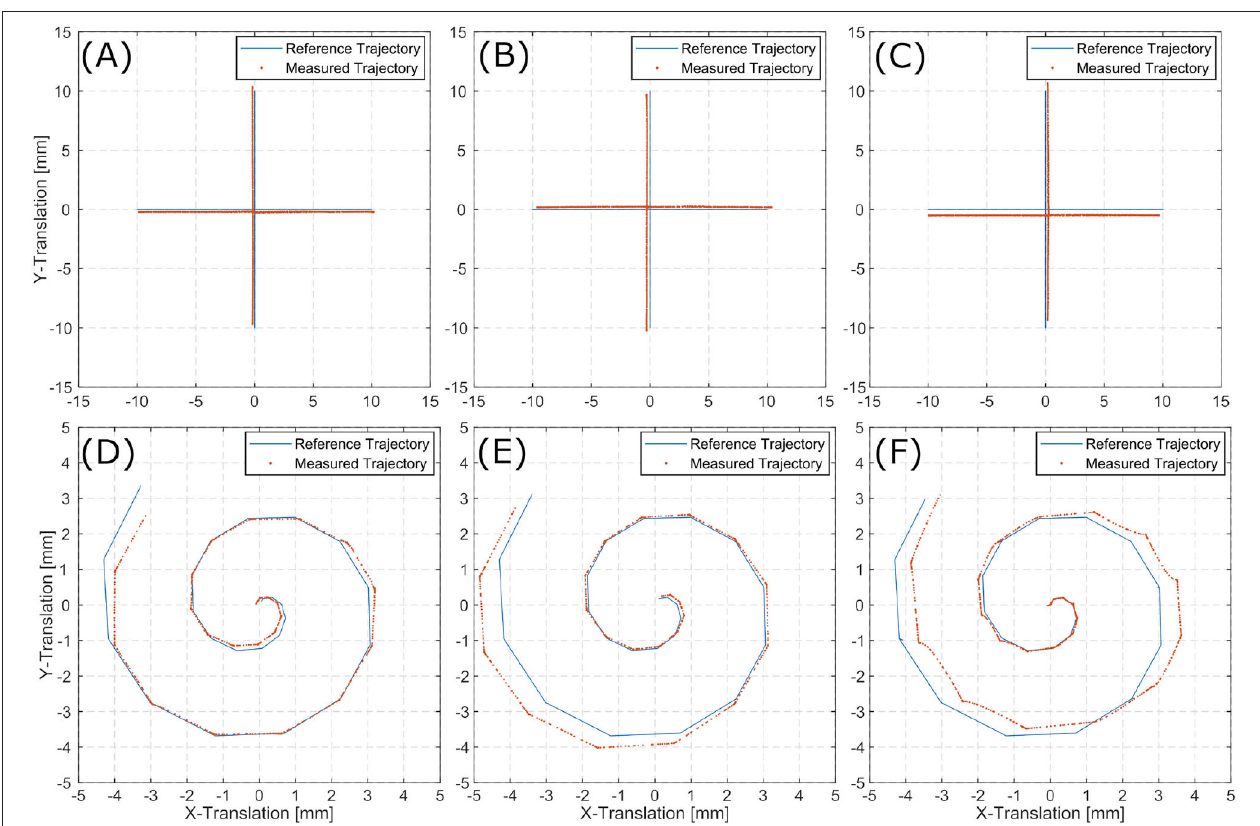
FIGURE 7 | Linear (A–C) and spiral (D–F) trajectories for TBP (A,D) , TBPs (B,E) , and CTP (C,F) .